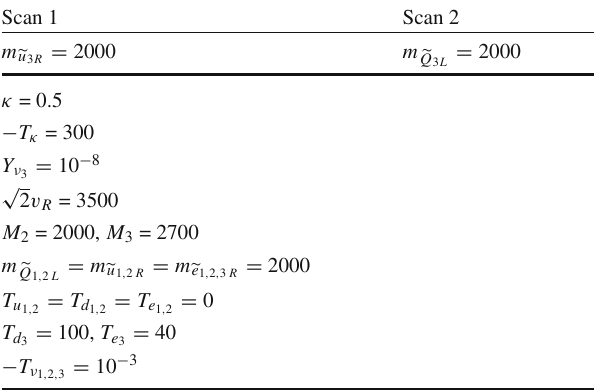
Table 2 Low-energy values of the input parameters that are fixed in the two scans. The VEV v R and the soft trilinear parameters, soft wino and gluino masses and soft scalar masses are given in GeV Scan 1 Scan